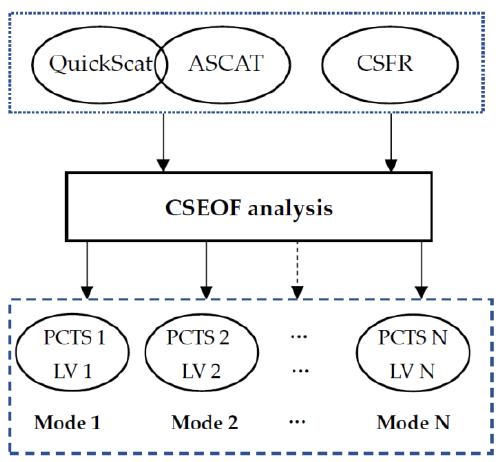
Figure 2. Flowchart of the CSEOF analysis of scatterometer and CFSR wind data.